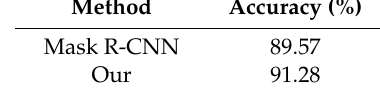
Table 2. Target area border average accuracy.